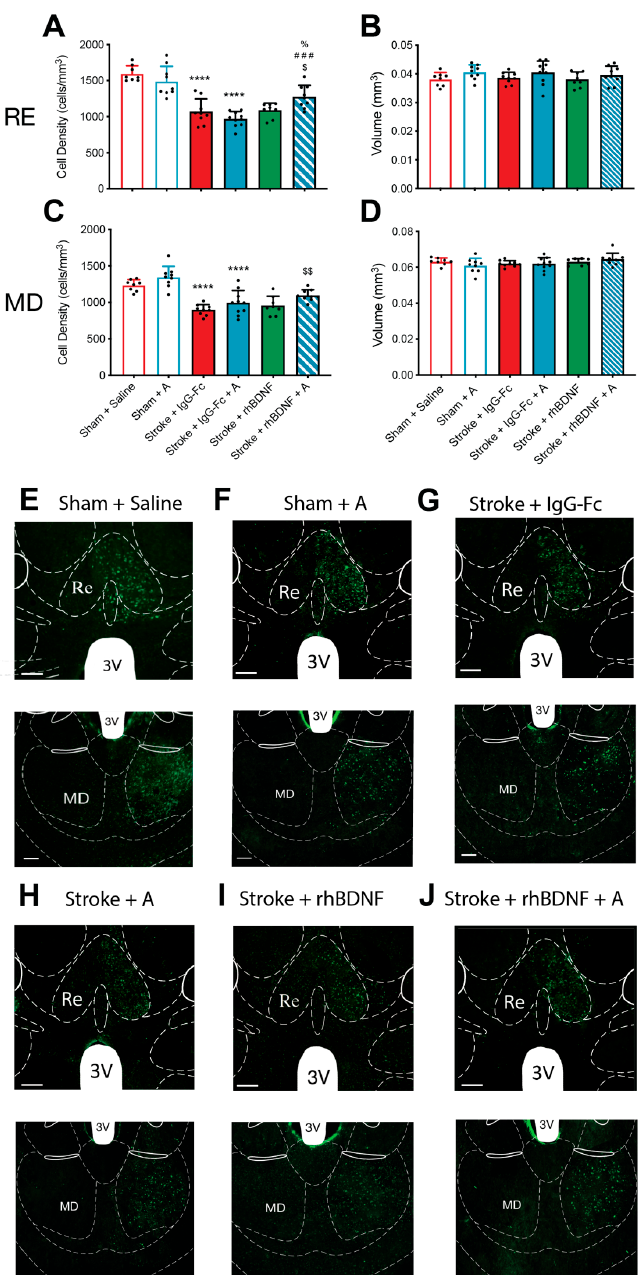
Figure 4. Effects of compound A treatment, with or without rhBDNF, on cholera toxin subunit B (CTB)+ve cell populations in the thalamus following PFC stroke. CTB+ve staining was quantified in the nucleus reuniens (RE, − 1.34 mm bregma) and mediodorsal thalamus (MD, − 1.34 mm bregma) at day-35 post-stroke. Stroke caused a significant reduction in the density of CTB+ve cells in the RE ( A ) and MD thalamus ( C ) of animals treated with a vehicle (sham + saline, n = 8; stroke + IgG-Fc, n = 8) or compound A (sham, n = 9; stroke, n = 10). Compound A failed to affect these CTB+ve cell densities in sham and stroke animals. Furthermore, combinational treatment with compound A + rhBDNF ( n = 9) significantly dampened the stroke-induced reduction in the density of CTB+ve cells within the RE and MD thalamus compared to all other experimental treatments. Lastly, no difference was observed in the volume of the RE ( B ) or MD thalamus ( D ) of all animals. Representative images of both thalamic regions are shown in ( E – J ). Two-way ANOVA: **** p < 0.0001, relative to vehicle- treated shams; One-way ANOVA: $ p < 0.05, $$ p < 0.01, relative to IgG-Fc; ### p < 0.001, relative to compound A; % p < 0.05. 3 V = third ventricle. Scale bar (white bar, bottom left) = 100 µ